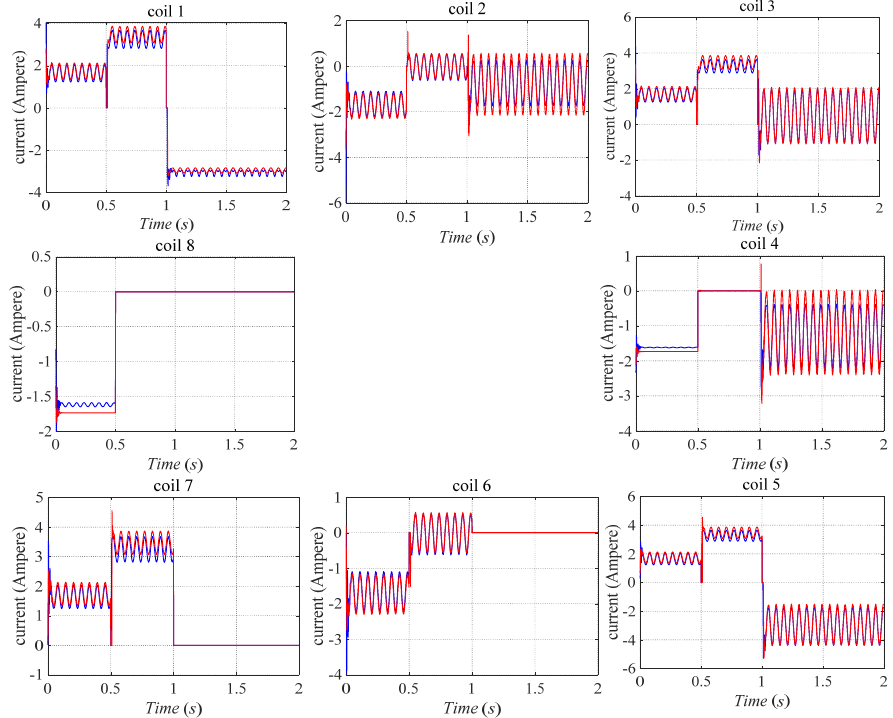
Figure 13. Current inputs of bearing A for a while the system under existing fault-tolerant control by red curve and proposed in this paper by the blue